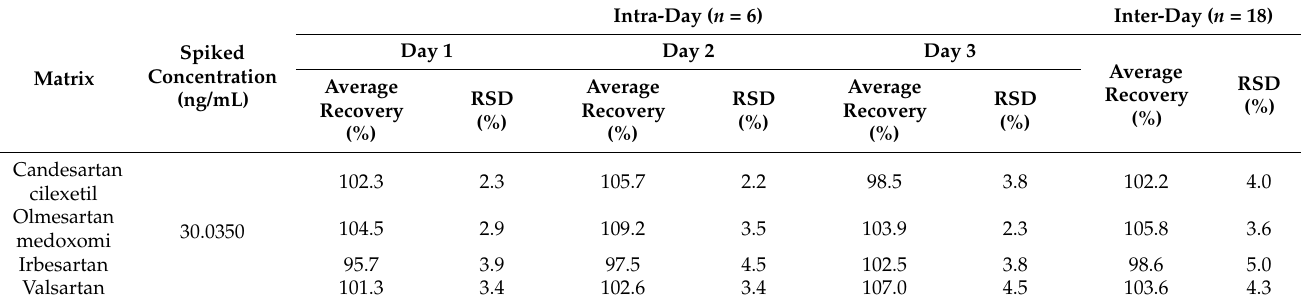
Table 5. Intra-day and inter-day precision of NMBA in sartan drugs.